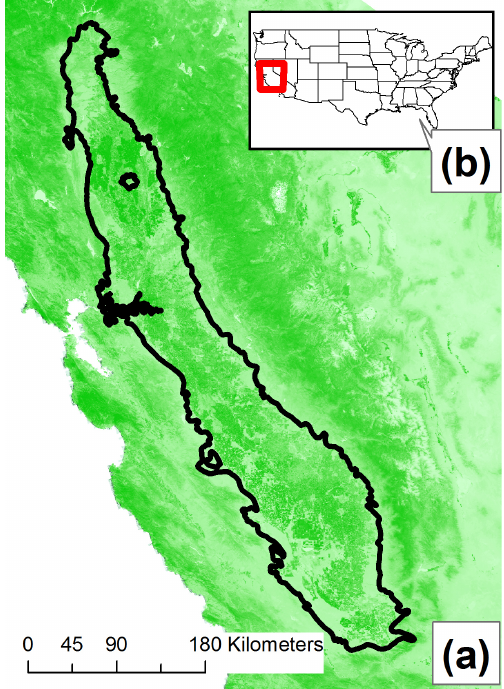
Figure 1. Map of the Central Valley, California. (a) Underlying normalized differential vegetation index (NDVI) from the MODer- ate resolution Imaging Spectroradiometer (MODIS) 250m, 16-day product (July 2006) illustrating irrigated regions of the Central Val- ley (black outline). Darker green indicates higher NDVI and vege- tation cover. (b) Map of the United States with the inset area of (a) outlined in